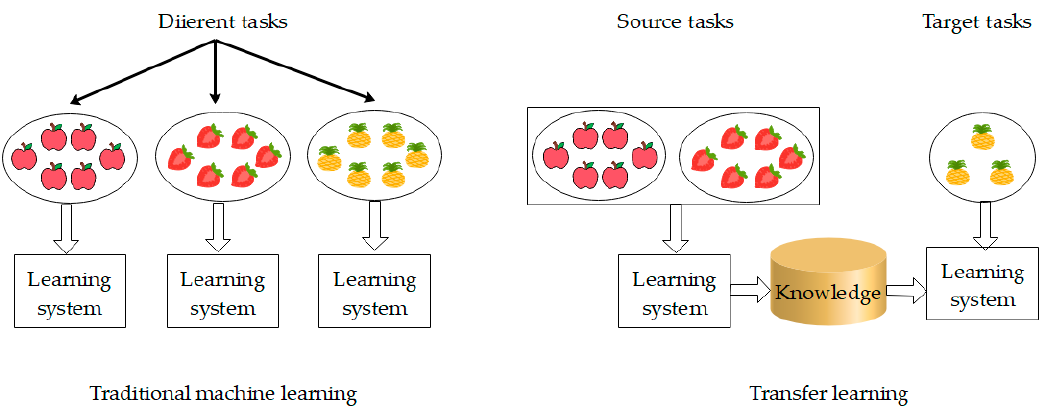
Figure 2. Difference between traditional machine learning and transfer learning.